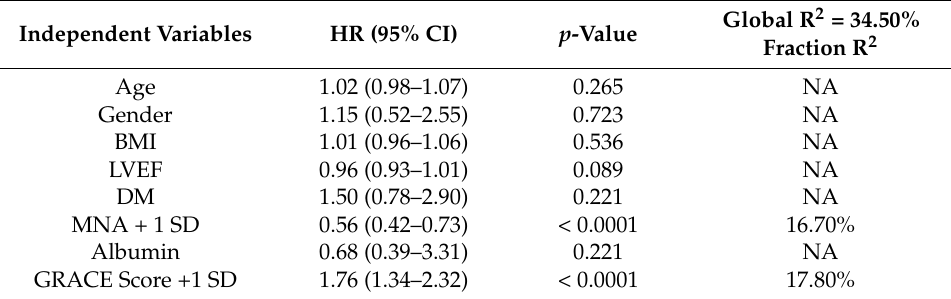
Table 2. Multivariable Cox proportional hazard regression model.